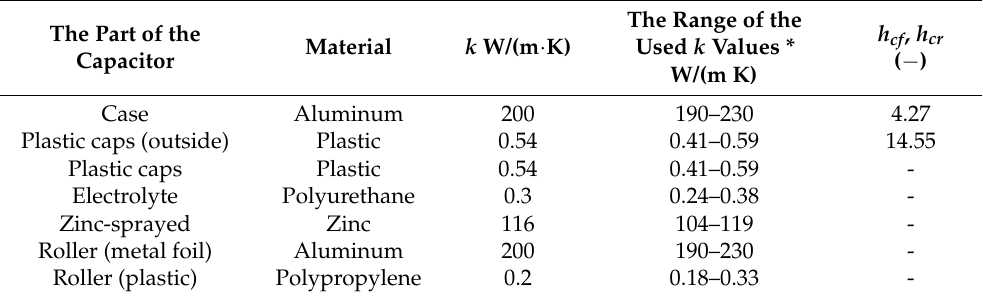
Table 2. Materials assigned to the individual parts of the capacitor, the selected value of thermal conductivity k (W/m k), and the selected values of the convection coefficients (for the external parts of the case).